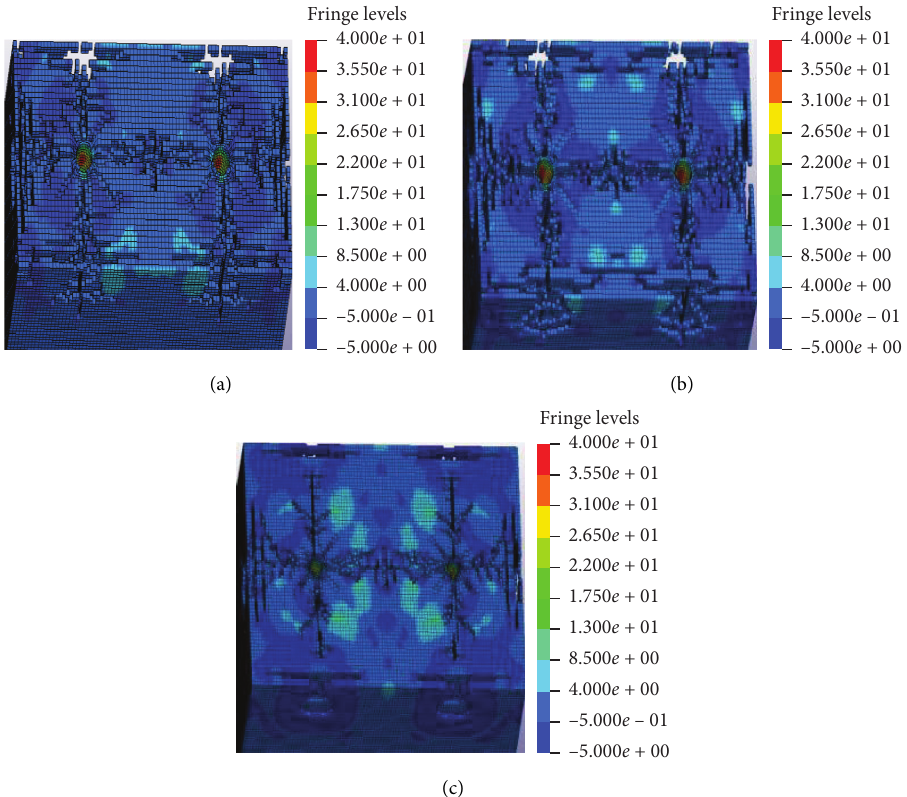
Figure 14: Simulation results of the concrete columns with different edge spacing. (a) b � 400mm. (b) b � 500mm. (c) b �